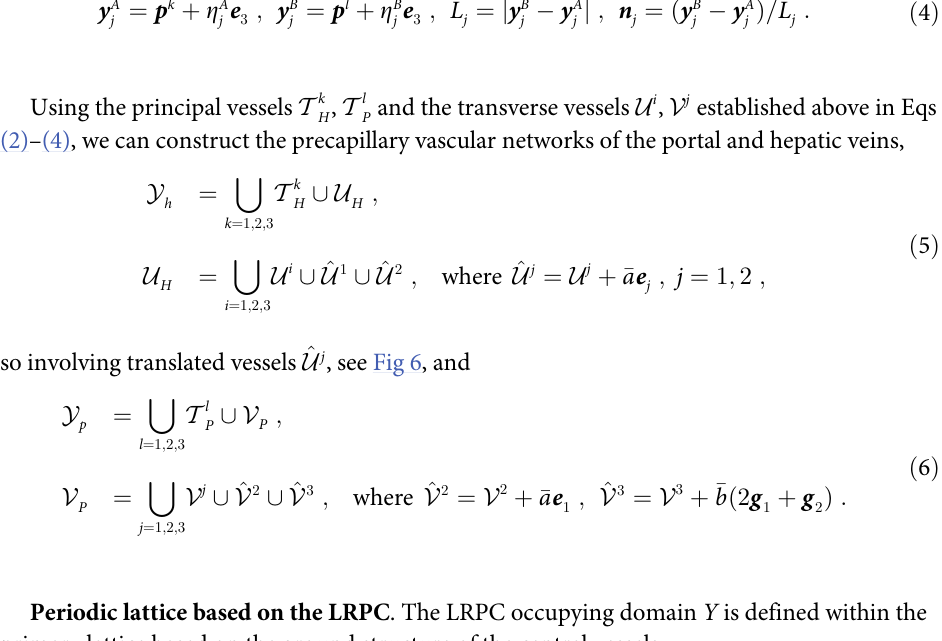
PLOS ONE | https://doi.org/10.1371/journal.pone.0260068 December2,